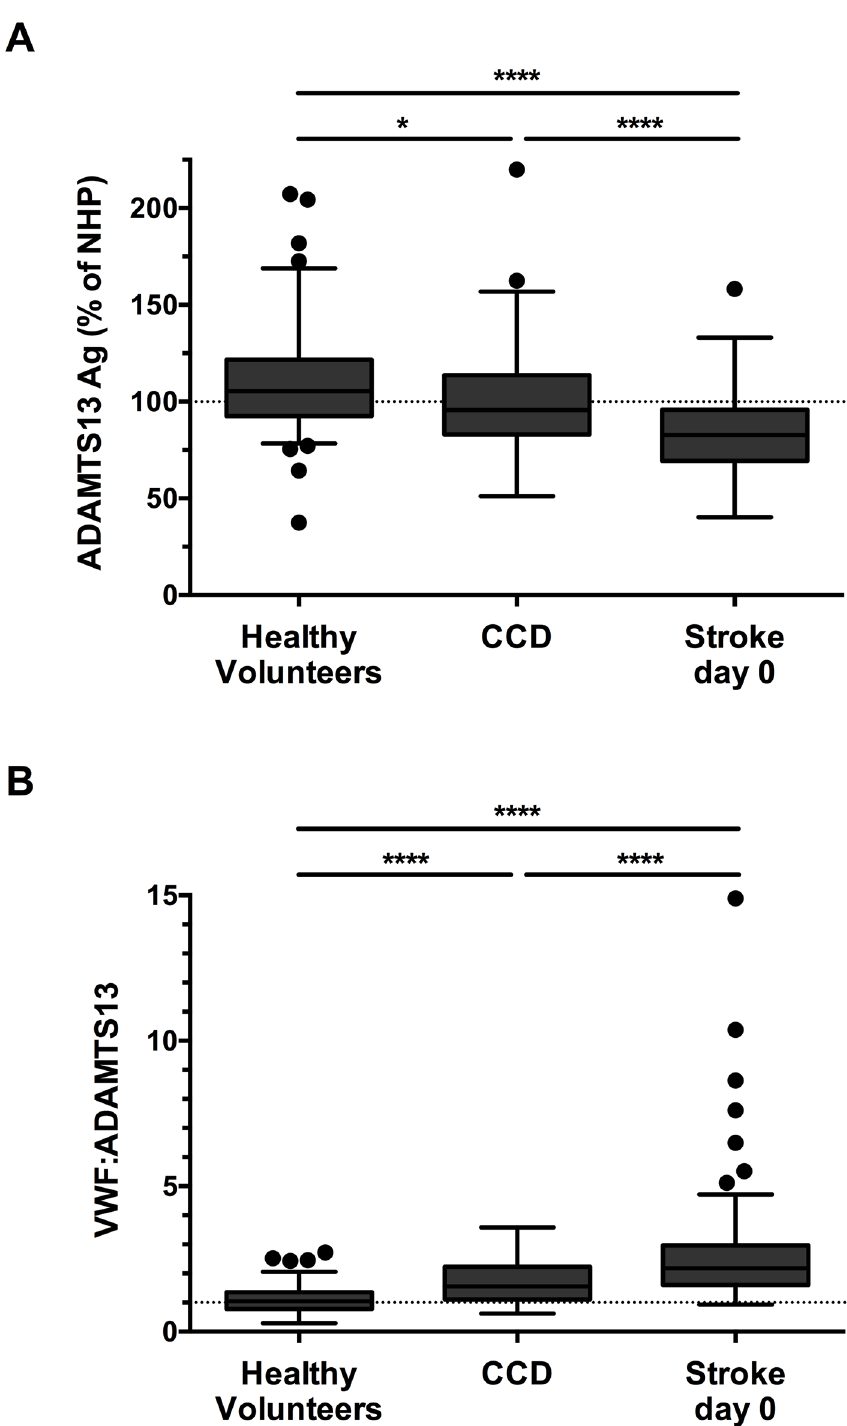
Fig 1. Patients with acute or chronic cerebrovascular disease have lower ADAMTS13 levels and a higher VWF:ADAMTS13 ratio compared to healthy volunteers. ADAMTS13 antigenlevels from 104 patients with acute ischemicstroke, 112 patients with a chroniccerebrovascular disease(CCD) and 85 healthyvolunteers, were measured. Levels of ADAMTS13 were plotted as a percentageof the level in a normalhuman plasma pool (NHP), consistingof pooledplasma from 20 healthy donors. VWF levels were measuredpreviously and were used to calculatethe VWF:ADAMTS13 ratios. Both ADAMTS13 levels [A] and